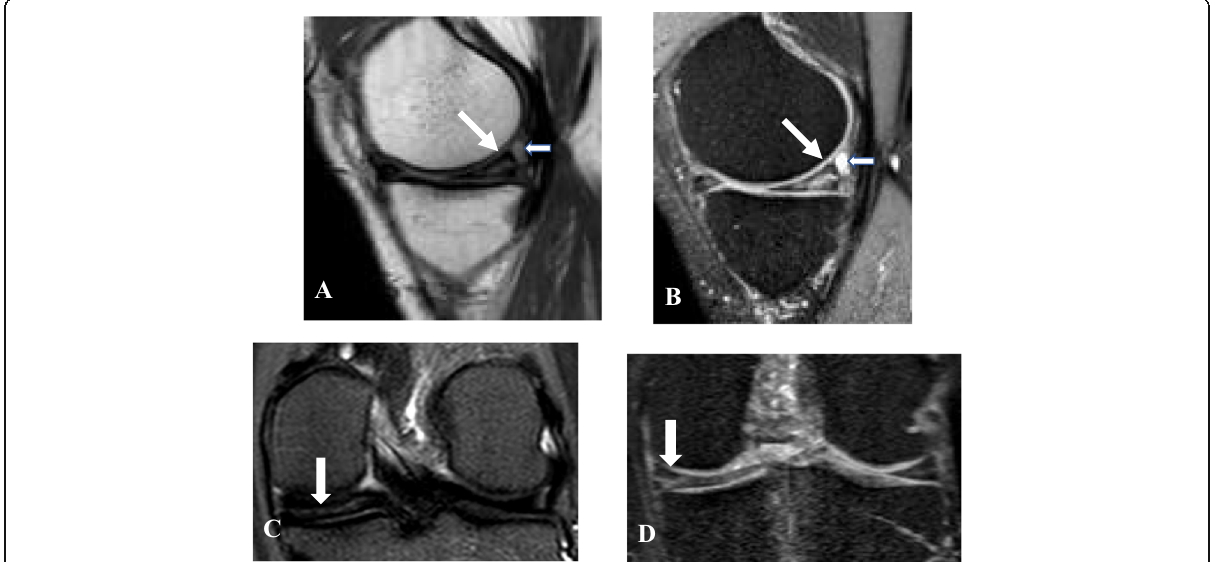
Fig. 1 A 32-year-old male patient presented with acute LT knee joint pain after trauma. a , b Sagittal standard 2D PDWI and 3D MPR VISTA images show horizontally oriented tear of the medial meniscus posterior horn (PHMM) (white arrows) with small related parameniscal cyst, with the tear clearly outlined in the VISTA images. c , d Coronal standard 2D PD and 3D MPR VISTA images again show the horizontal tear of the PHMM (white